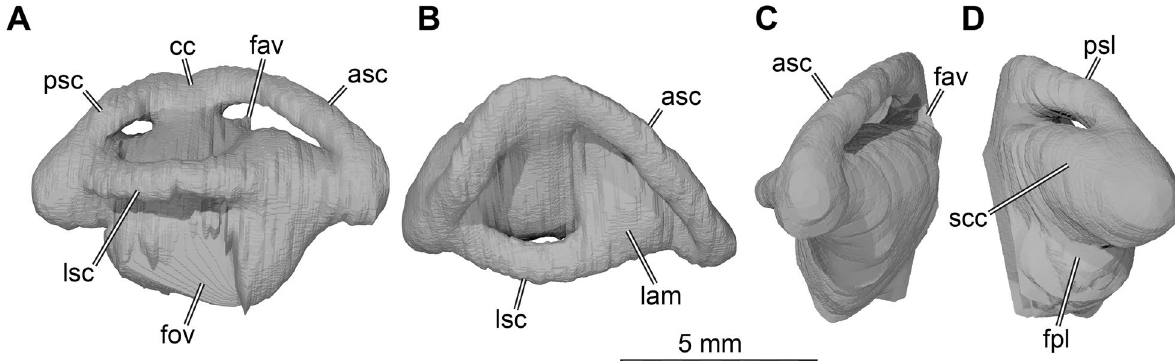
Fig. 10 Three dimensional renderings of the right endosseous labyrinth of Plastomenus thomasii (AMNH FR 6015). A lateral view; B dorsal view; C anterior view; D posterior view. Note that the fenestra ovalis region is incomplete due to breakage along the prootic and opisthotic. Also, the endocast of the fenestra perilymphatica is incomplete due to breakage. asc anterior semicircular canal, cc common crus, fav foramen aquaducti vestibuli, fov fenestra ovalis, fpl fenestra perilymphatica, lam lateral ampulla, lsc lateral semicircular canal, psc posterior semicircular canal, scc secondary common